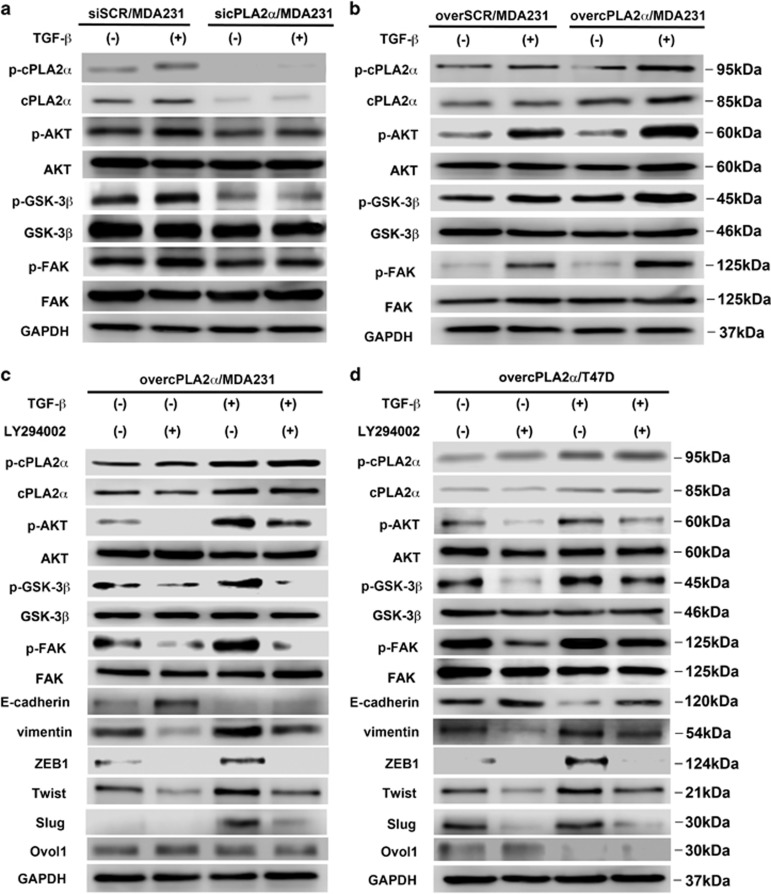
Activation of cPLA2α mediated TGF-β-induced EMT through the PI3K/Akt/GSK-3β pathway. Western blot of phosphorylated cPLA2α, FAK, Akt, GSK-3β and total cPLA2α, FAK, Akt, GSK-3β in (a) siSCR/MDA-MB-231 and sicPLA2α/MDA-MB-231 cells when cultured without or with TGF-β (5 ng/ml, 72 h); (b) overSCR/MDA-MB-231 and overcPLA2α/MDA-MB-231 cells when cultured without or with TGF-β (5 ng/ml, 72 h); western blot of phosphorylated cPLA2α, FAK, Akt, GSK-3β; total cPLA2α, FAK, Akt, GSK-3β and EMT-associated markers and transcription factors in (c) overcPLA2α/MDA-MB-231 cells when cultured without or with TGF-β (5 ng/ml, 72 h) and LY294002; (d) overcPLA2α/T47D cells when cultured without or with TGF-β (5 ng/ml, 72 h) and LY294002. All experiments were repeated at least three times